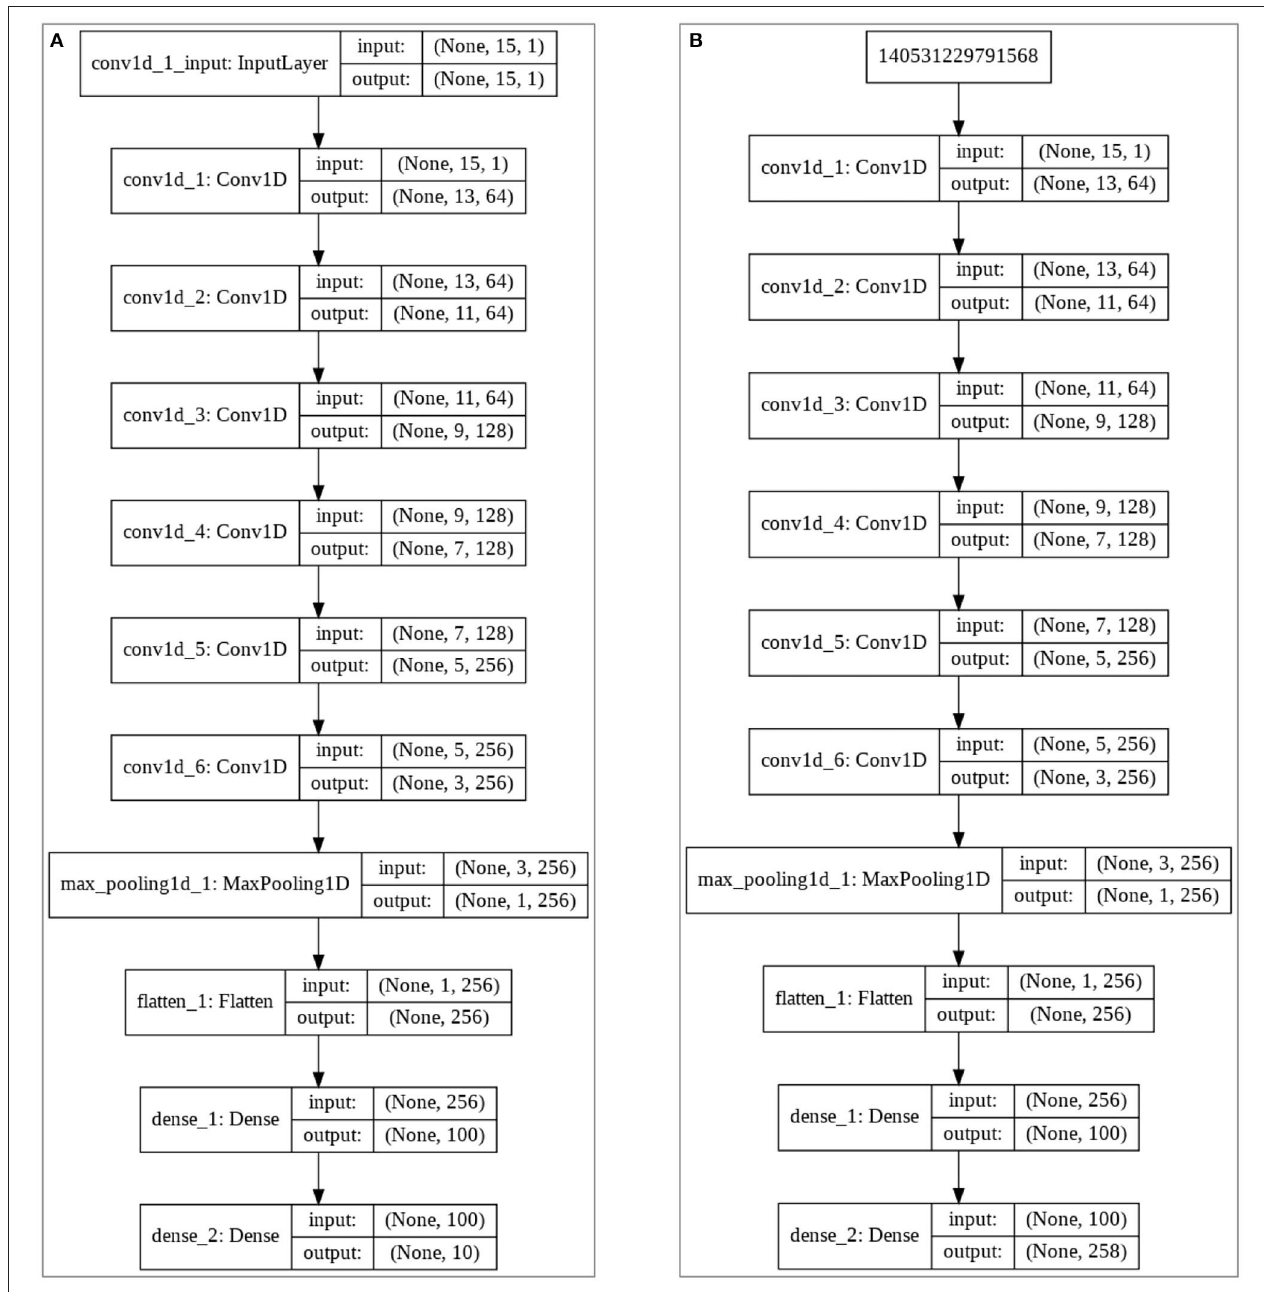
FIGURE 5 | CNNAI matching model (A) FVC2004 (B) NIST